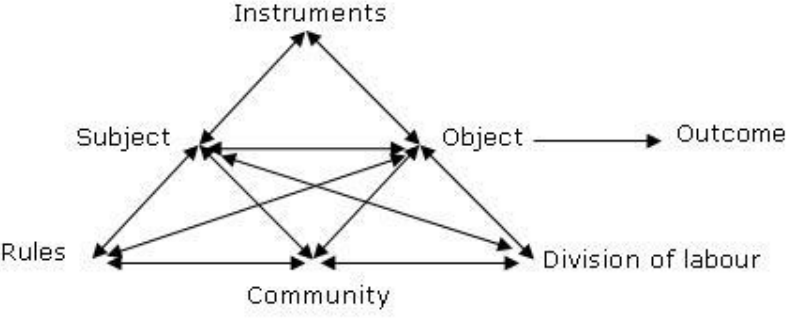
Figure 1. Activity theory diagram (Engeström,